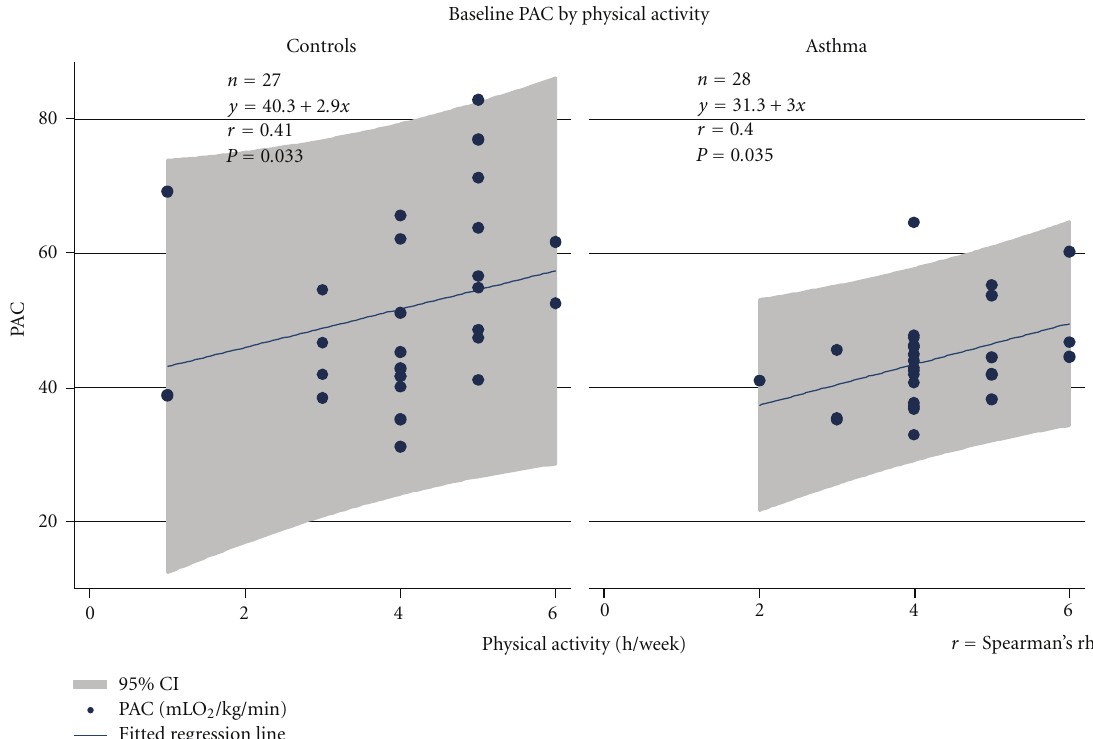
Figure 3: Baseline associations between PAC (mLO 2 /min/kg) and physical activity (h/week) in asthmatics and controls.